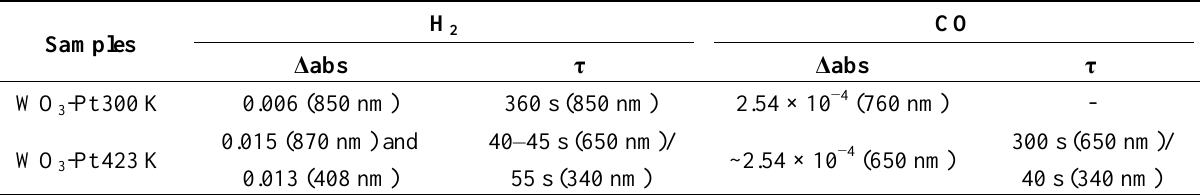
Table 3. Table summarizing gas responses and response